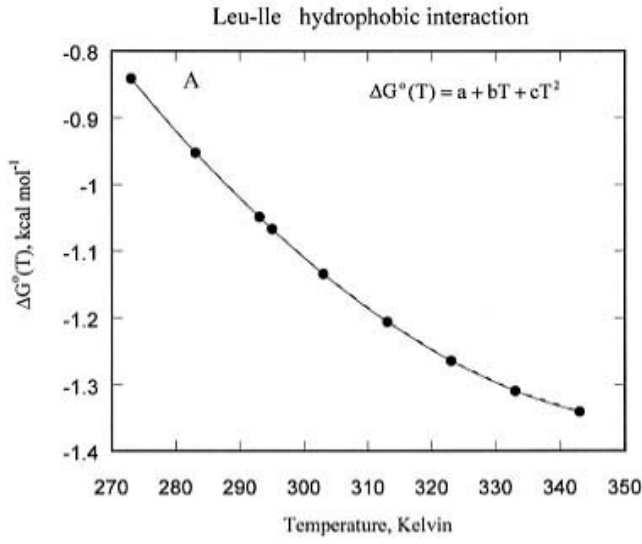
FIGURE 3A . Thermodynamic plot of the standard Gibbs free energy change of Leu-Ile hydrophobic interaction. Values for ∆ G o (T) as a function of temperature were computed from Nemethy and Scheraga’s Table II[8] in the temperature range 273–333 K, using the general linear polynomial model (T 2 model: ∆ G o (T) = a + bT + cT 2 ) procedure of statistical analysis of IMSL subroutine. The solid line represents fitted data. F = 0.0001, thus the goodness of fit of the experimental data was 99.99% or better in each